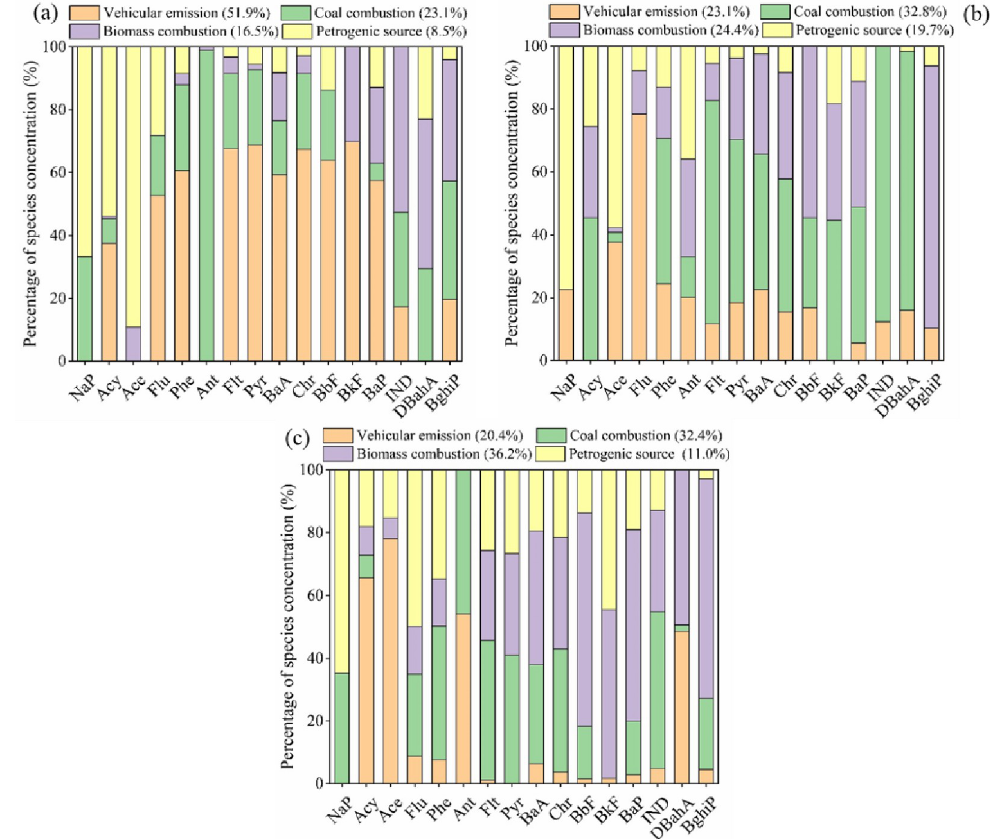
Fig 2. Source profiles of each PMF factor for PAHs in urban soils (a), suburban soils (b) and rural soils (c).